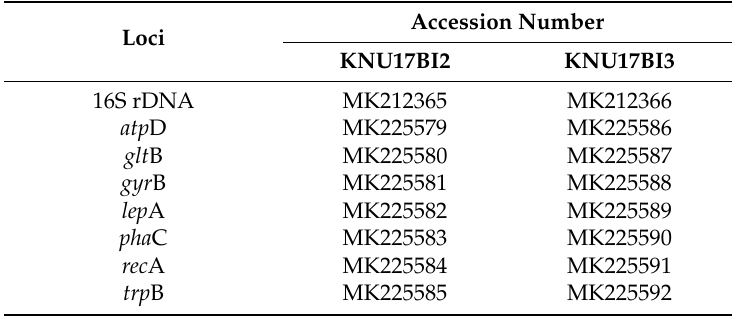
Table 4. Genebank accession numbers of strain KNU17BI2 and